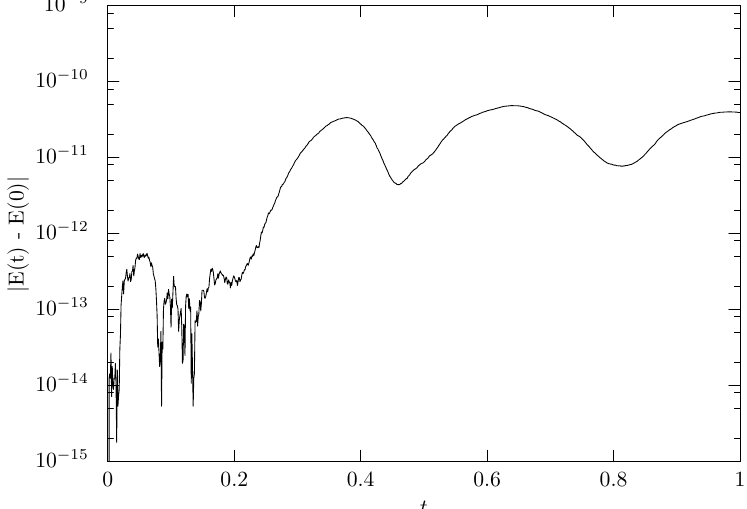
Figure 4. The deviation of the total energy in Equation (91) from the initial value of the coupled systems in Equations (87)–(89) without the damping terms. The energy is preserved up to the accumulation of the rounding